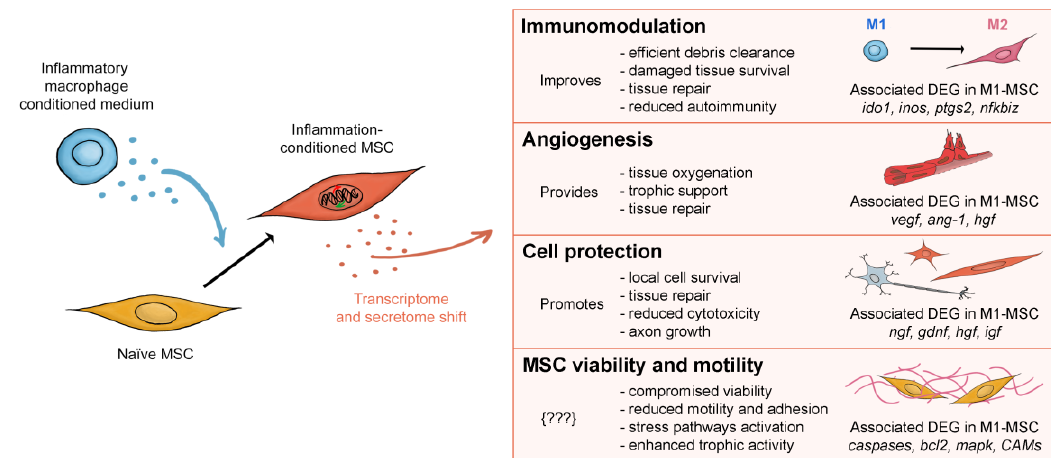
Figure 7. Graphic summary. Macrophage-derived inflammatory conditioning induces changes in the transcriptome and secretome of bone marrow-derived MSCs. Conditioned MSCs have increased expression levels of genes that are known to participate in immunosuppressive and immunomodulatory events (e.g., ido1 , nos2, il13r, ptgs2, hif1 α , nfkbiz ), suggesting that macrophage-derived inflammation potentiates the immunomodulatory ability of MSCs. Similarly, conditioning induced higher levels of expressed genes (e.g., vegf , ang-1 , hgf, egf, hif1) and secreted growth factors known to promote angiogenesis, indicating the potentiation of MSC angiogenic ability. Inflammatory conditioning also increased the expression of genes associated with the promotion of tissue repair and cell survival (e.g., ngf, gdnf, igf1, bmp). Given that immunomodulation, angiogenesis and the promotion of cell survival are synergistic events that are essential to tissue repair, our work suggests that macrophage-derived inflammatory conditioning of MSCs before transplantation may enhance the therapeutic potential of MSCs transplants. On the other hand, our data also show that conditioned MSCs show signs of apoptosis, arrested cell cycle and reduced motility, because genes related to cell death and apoptosis are upregulated, while survival genes (i.e., bcl-2 ) are downregulated. The impact of these challenges on the therapeutic potential of MSCs transplants is yet unknown, so further research is needed to better understand and optimize the conditioning method. In the chart, we sum- marize the sub-phenomena that result from enhancing the respective physiological processes in damaged tissue. The curved arrows, on the left, represent the effect of macrophages’ (blue) or conditioned-MSC’ secretomes on other cells, while the straight black arrow represents a phenotype transition from naïve MSC to conditioned MSC. Abbreviations: MSC = mesenchymal stromal cell; M1 = pro-inflammatory macrophage; M2 = anti-inflammatory macrophage; DEG = differentially expressed genes; M1-MSC = macrophage-derived inflammation-conditioned MSC; {???} = unknown effect on the therapeutic efficacy of pre-conditioned MSC transplants; CAMs = cell adhesion molecule-related